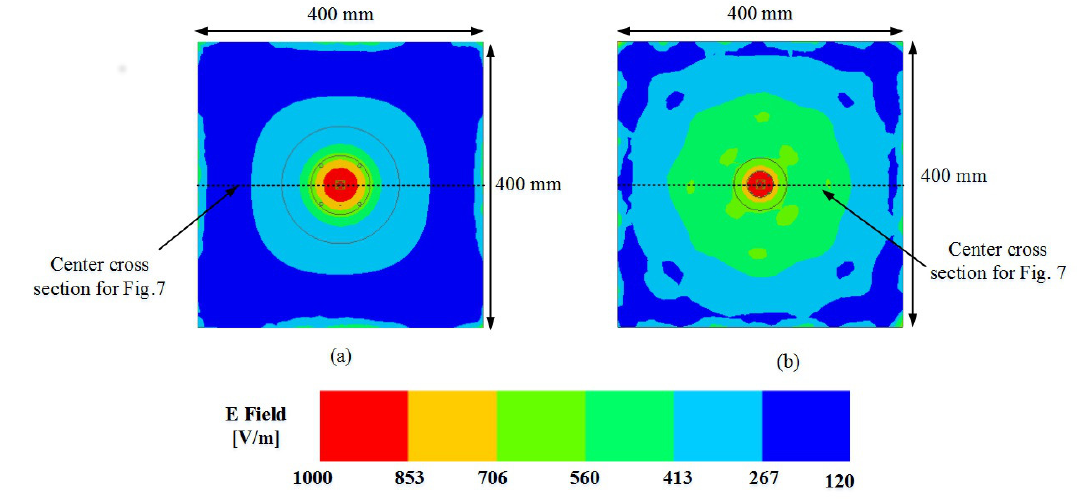
Figure 6. Simulated E-field distribution with input power of 12 W ( a ) L-probe antenna for 1.2–1.4 GHz at the center frequency of 1.3 GHz (1st E-probe); and ( b ) L-probe antenna for 2.7–3.1 GHz at the center frequency of 2.9 GHz (2nd